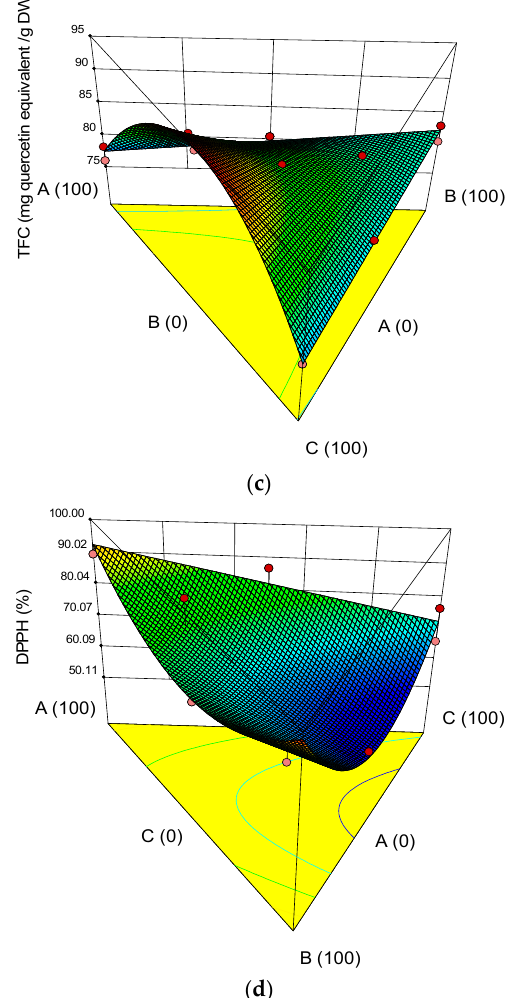
Molecules 2022 , 27 , 8509 16 of 19 Figure 3. Estimated response surface plots indicating effect of sodium caseinate (SC), pectin (P), and whey protein isolate (WPI) levels on physical parameters: ( a ) Microencapsulation Efficiency, ( b ) TPC, ( c ) TFC, ( d ) DPPH, Free radical scavenging capacity in encapsulated freeze-dried onion’s extract.